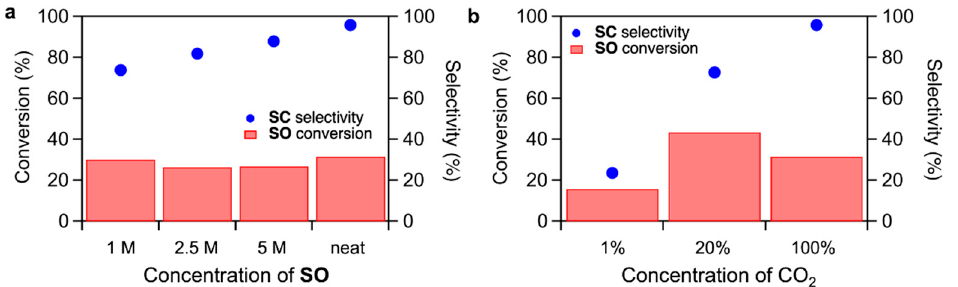
Figure 4. Effect of ( a ) SO concentration and ( b ) CO 2 concentration with N 2 balance. Reaction conditions: ( a ) TBA-Ta 1 Nb 5 = 5 µmol, DMSO = 1 mL, SO = 0.6 mL (ca. 5 mmol for neat condition), 100% CO 2 = 0.1 MPa, temperature = 100 ° C, reaction time = 6 h; ( b ) TBA-Ta 1 Nb 5 = 5 µmol, SO = 0.6 mL (ca. 5 mmol), neat, CO 2 (0.1 MPa), temperature = 100 ° C, reaction time = 6 h.